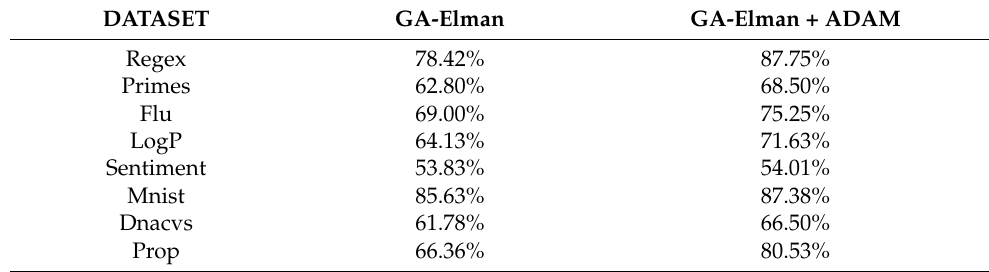
Table 1. Experimental results on selected